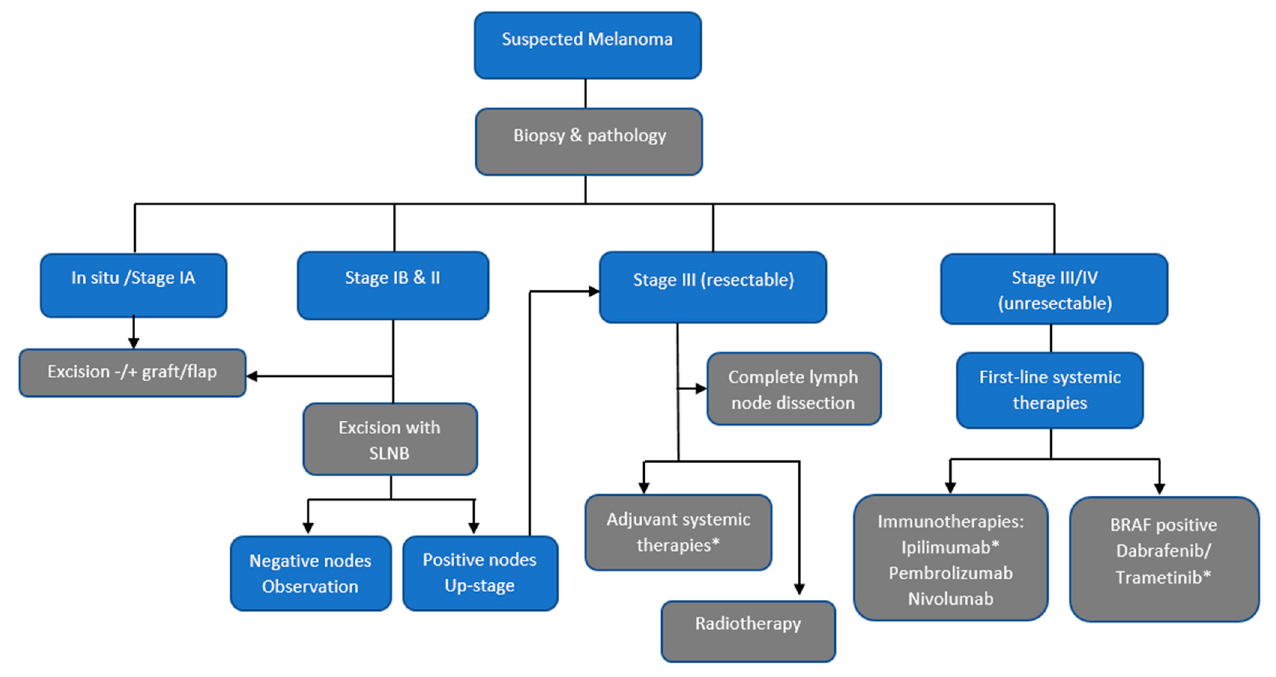
Figure 1. Main pathways for treatment of melanoma. * Adjuvant systemic therapies for resectable stage III melanoma or ipilimumab, dabrafenib/trametinib for unresectable stage III or IV melanoma are not subsidised in NZ, and these were omitted from the NZ model, and interferon therapy was added. SLNB = sentinel lymph node biopsy.